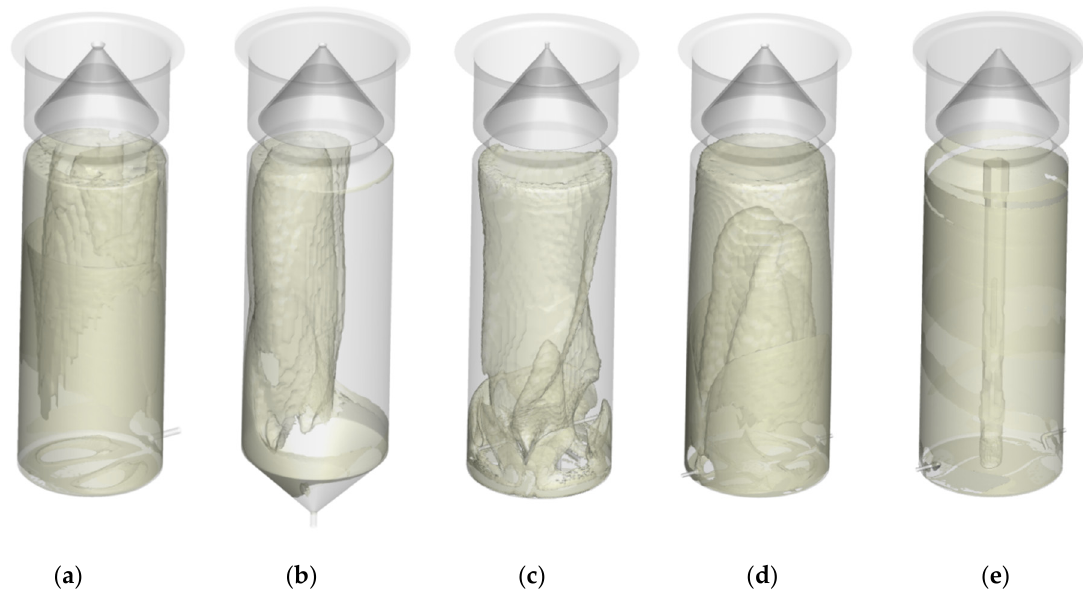
Figure 6. Granulation volume in pale yellow. ( a ) Case 1; ( b ) Case 2; ( c ) Case 3; ( d ) Case 4; ( e ) Case 5.